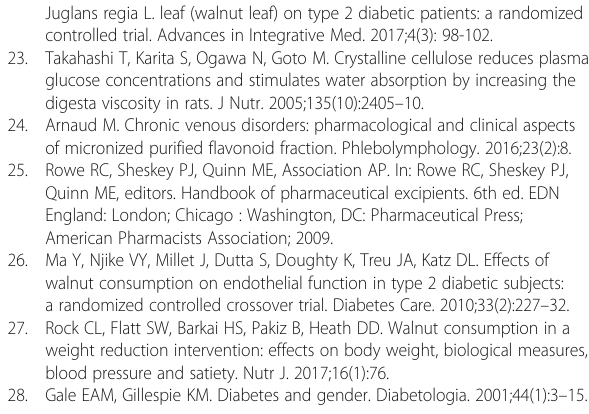
Juglans regia L. leaf (walnut leaf) on type 2 diabetic patients: a randomized controlled trial. Advances in Integrative Med. 2017;4(3): 98-102. 23. Takahashi T, Karita S, Ogawa N, Goto M. Crystalline cellulose reduces plasma glucose concentrations and stimulates water absorption by increasing the digesta viscosity in rats. J Nutr. 2005;135(10):2405 – 10. 24. Arnaud M. Chronic venous disorders: pharmacological and clinical